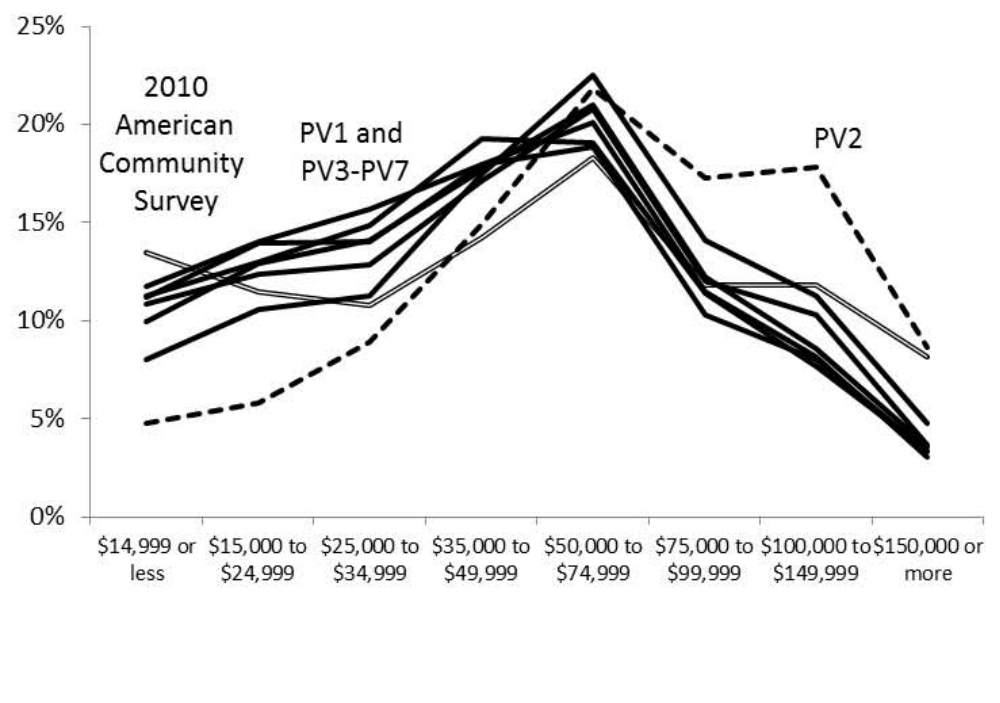
Figure 5. Weighted proportion of respondents who passed screener by annual household income in 2011 and panel vendor (PV).